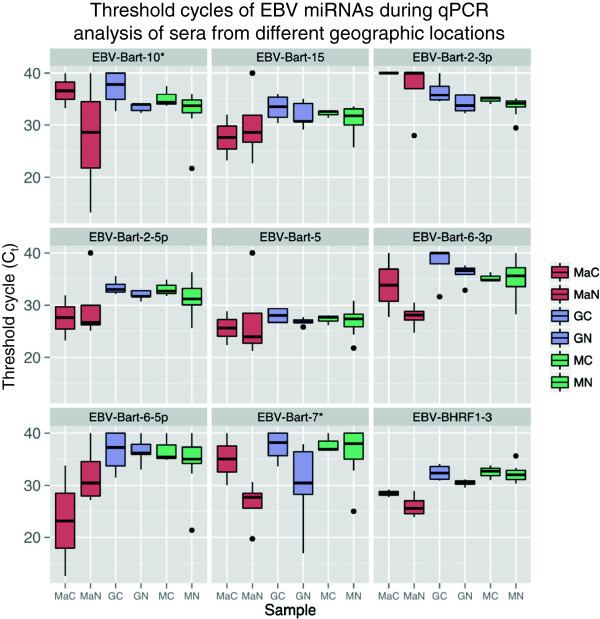
Box and whisker plots of EBV miRNA expression levels in sera determined using qPCR. Nine miRNAs were selected for qPCR based on their overexpression in FFPE NPC tissue. Box and whisker plots of the threshold cycle (Ct) values are shown for all miRNAs according to the geographical origin of the sera. MaC/MaN – Massachusetts control and test samples respectively (red); GC/GN – German control and test samples respectively (purple); and MC/MN – Malaysian control and test samples respectively (green). Boxes encompass the range between the upper and lower quartiles and whiskers extend to high/lowest values outside these bounds. Outliers, defined as greater/less than the upper/lower quartile by more than 1.5 times the interquartile range, are plotted as points.